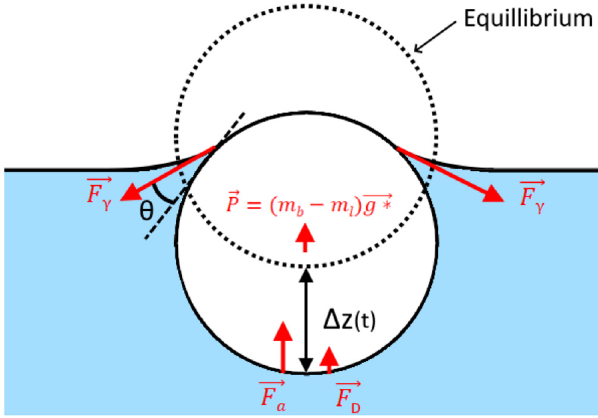
Fig. 4. Forces acting on the ball in the reference frame of the cup. θ is the contact angle, and the red arrows show the capillary force F γ , the apparent weight modified by the Archimedes’ P (with g ∗ the apparent gravity), the added mass force F a and the drag force F D . ∆ z represents the difference between the position of the ball at equilibrium (dotted circle) and during the free fall of the cup (black circle).